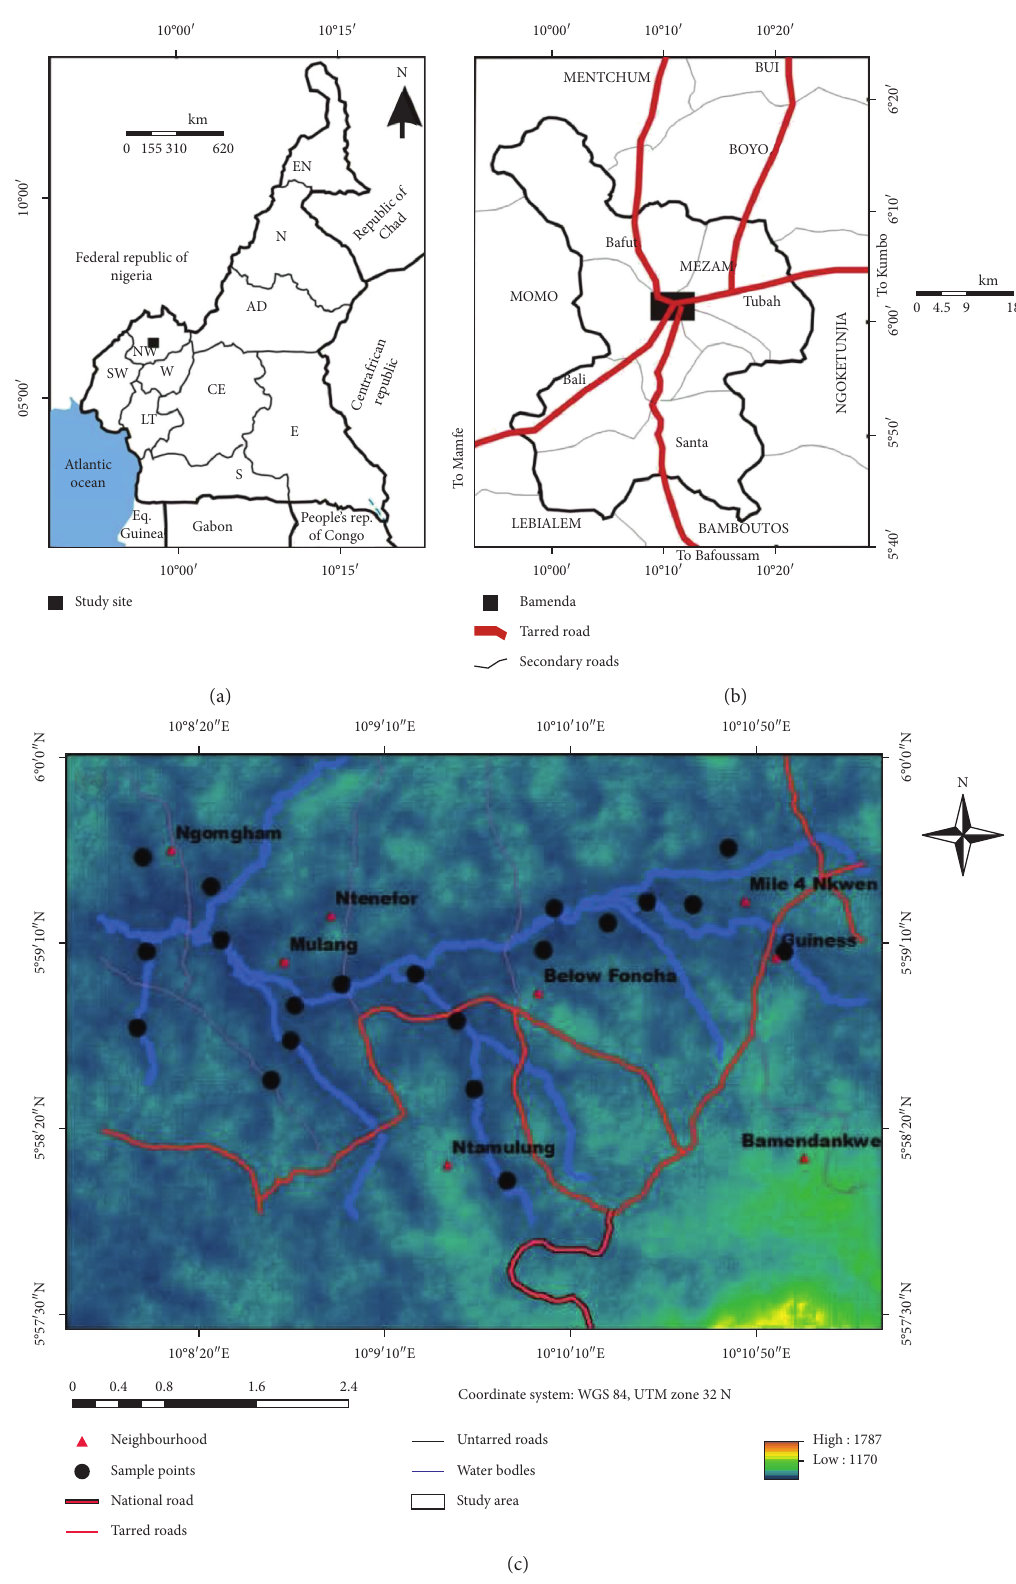
Figure 2: Location maps of the study area: (a) location of Mezam Division in Cameroon; (b) location of Bamenda in Mezam Division; (c) studied site map with sampling